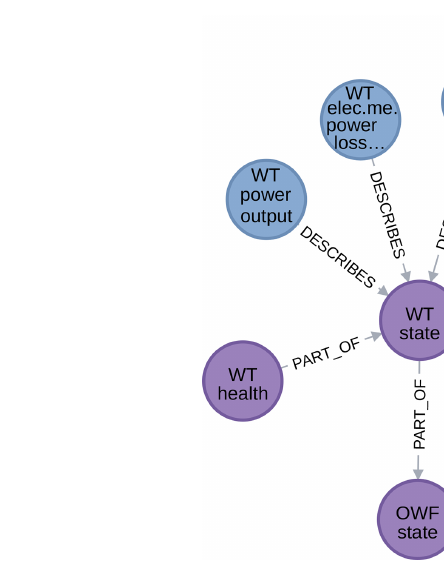
Figure 11. An example implementation of the top-level attribute state, structure, and cost name convention (excerpt from